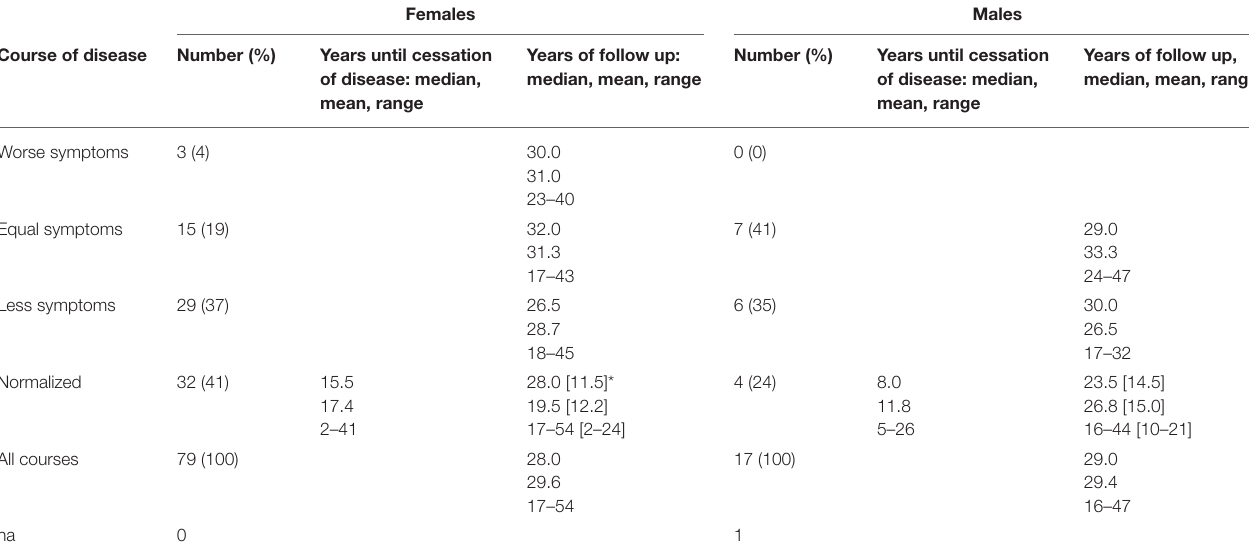
TABLE 3 | Course of